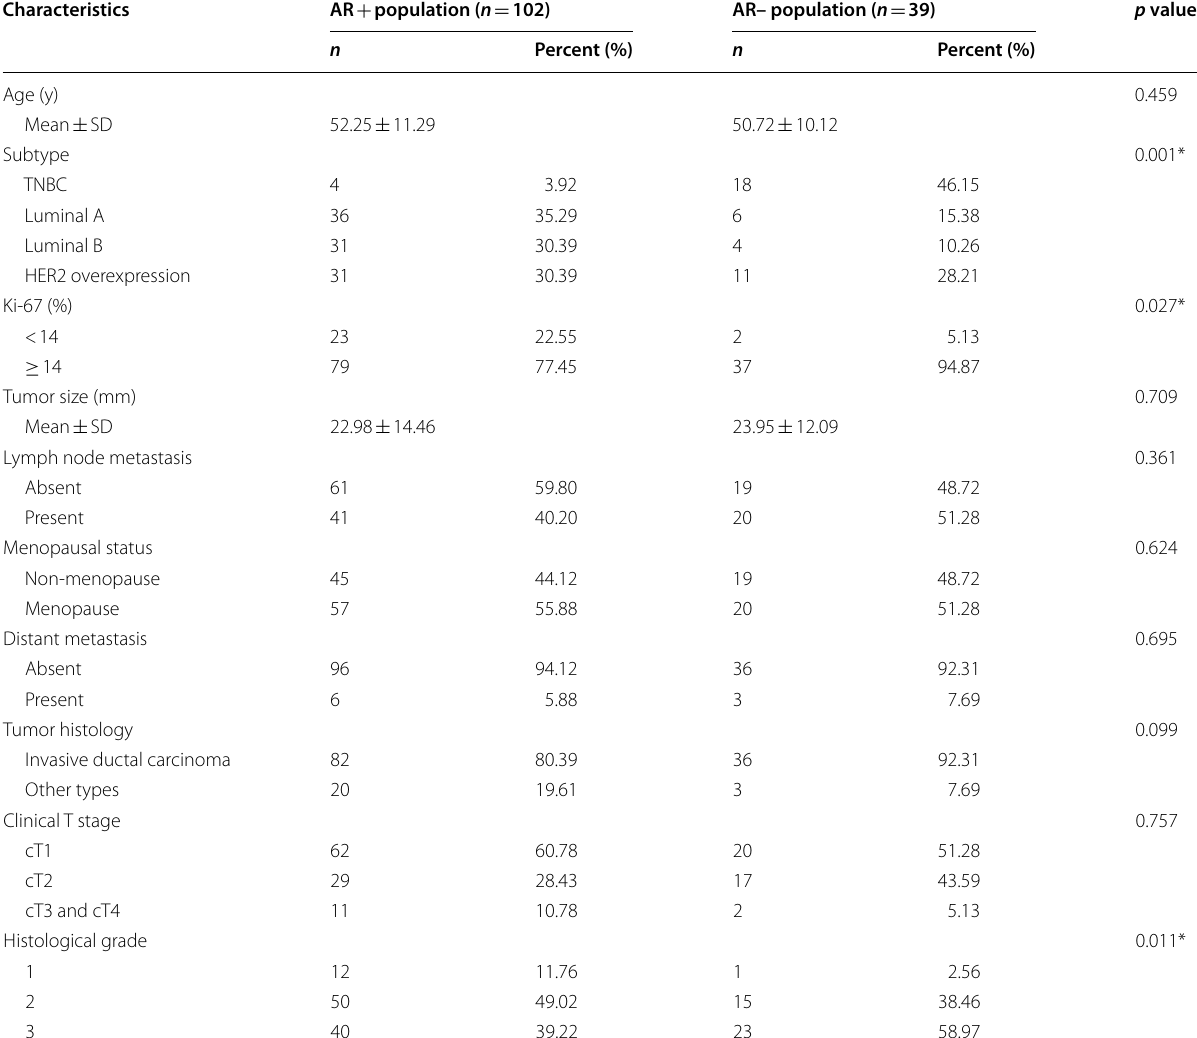
Table 1 Summary data of clinicopathological features of 141 patients